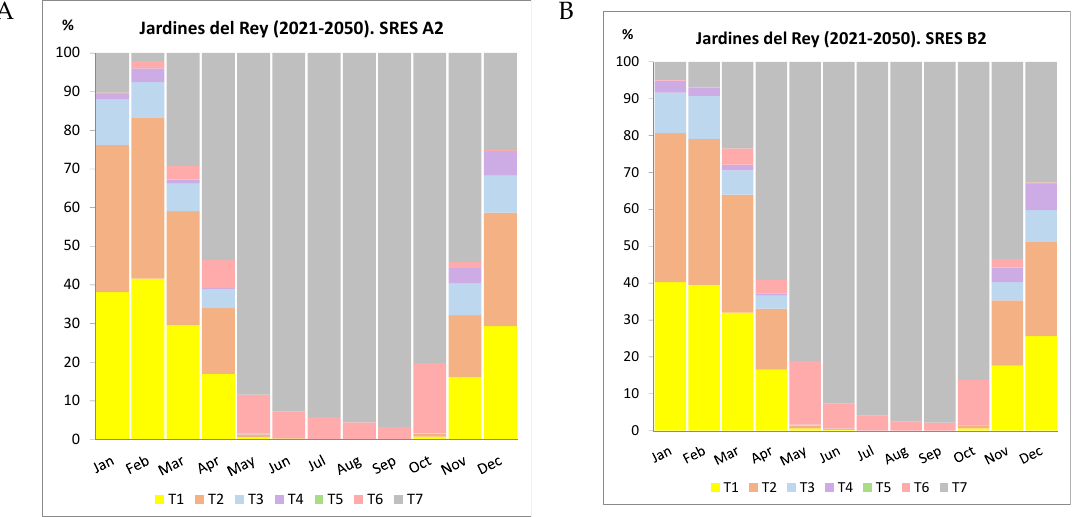
Figure 3. Annual distribution of weather types in Jardines del Rey (2021–2050, scenarios A2 and B2). (A) scenario A2 (B) scenario B2.